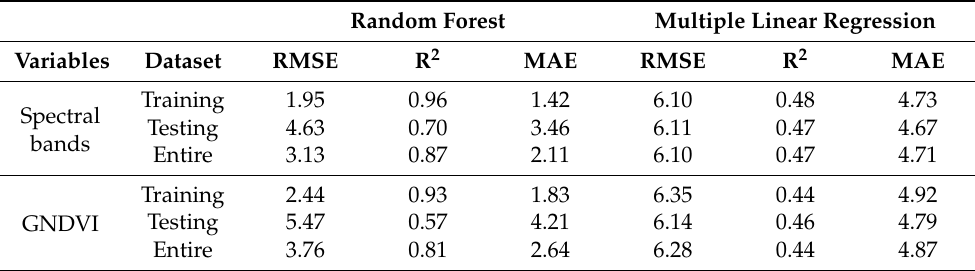
Figure 3. The most important variables in decreasing order according to the Mean Squared Error based on the Random Forest (RF) regression applied for the predictor variables: Spectral bands ( A ). Green Normalized Difference Vegetation Index—GNDVI ( B ). Normalized Difference Red-Edge—NDRE ( C ). Normalized Difference Vegetation Index—NDVI ( D ). Wide Dynamic Range Vegetation Index—WDRVI ( E ). Table 6. Results of Random Forest and Multiple Linear Regression algorithms to predict the sugar- cane